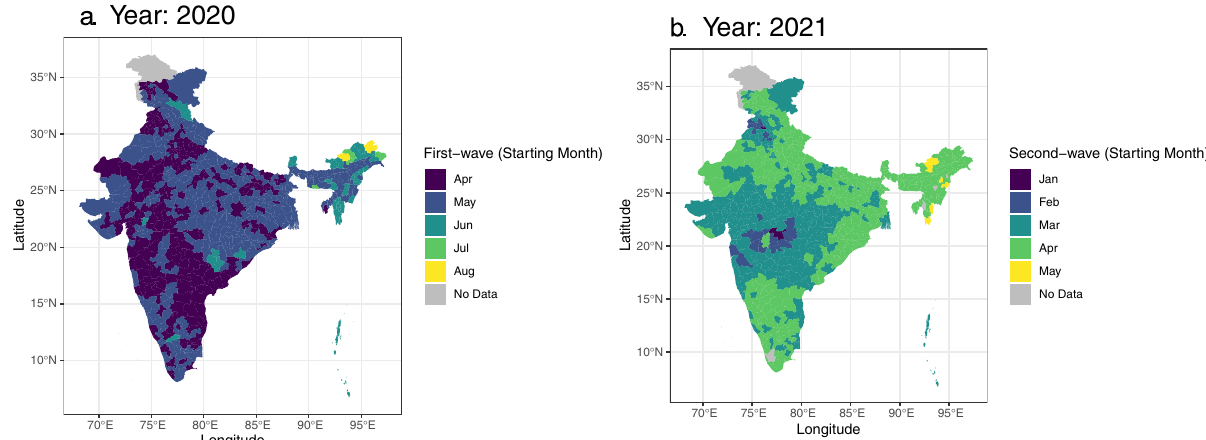
Fig. 2 COVID-19 onset timing across districts. Estimated COVID-19 wave onset month for the fi rst ( a ) and the second ( b ) wave across districts. Districts with no data are fi lled with gray color. Spatial patterns of onset months for the fi rst wave (left) highlight multiple leading districts, whereas the second-wave (right) patterns emphasize a few concentrated leading districts.